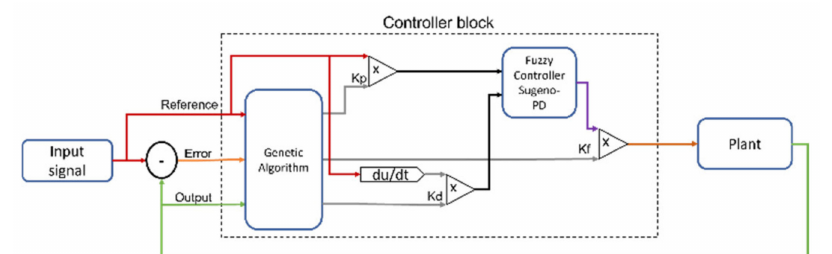
Figure 11. Autotuned GA–Sugeno